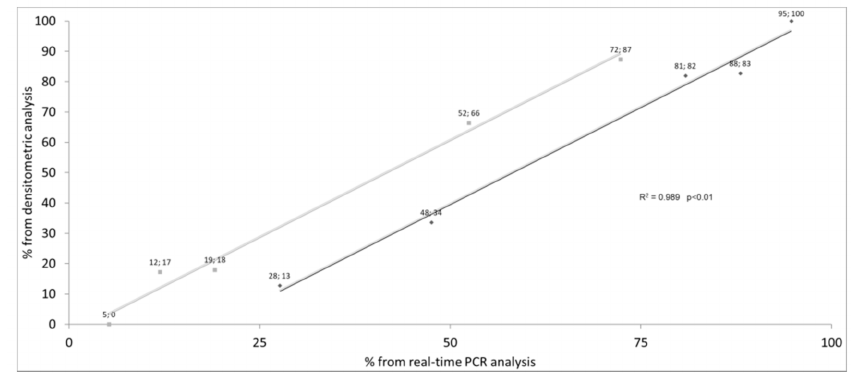
Figure 4. Correlation between densitometric and real time polymerase chain reaction (PCR) analysis. Each (TG)mTn genotype is represented as a point, both for exon 10+ (dark grey) and for exon 10 − (light grey). On the x and y axes, the average percentage values of exon 10+ and exon 10 − obtained by, respectively, real time PCR and densitometric analysis are